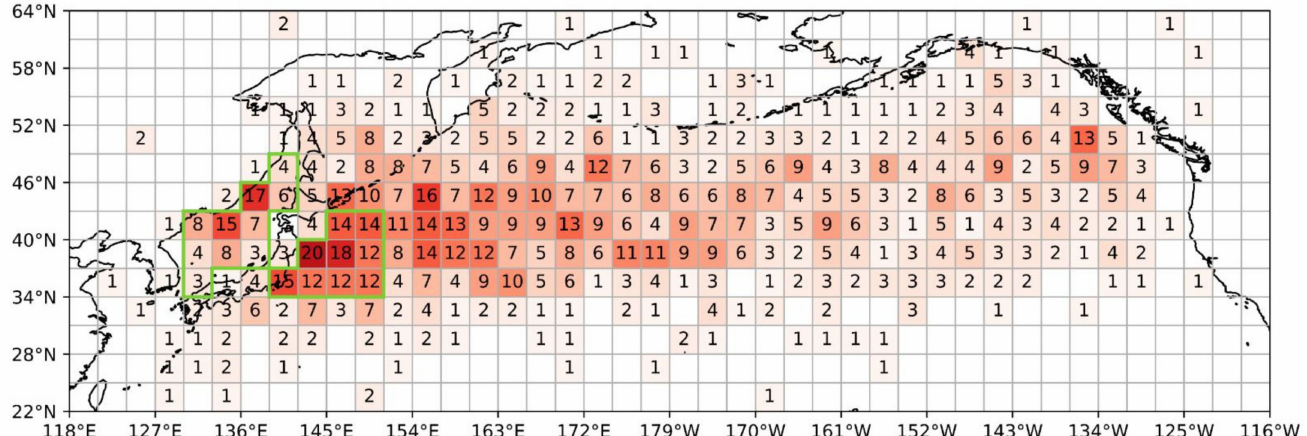
Figure 1. Frequency of ECs with the maximum-deepening-rate position within the 3 ◦ × 3 ◦ box over the northern Pacific during 15-year (2000–2015) cold-seasons (October–April). ECs in regions outlined by green lines over the Japan Sea and Kuroshio/Kuroshio Extension are selected for the composite